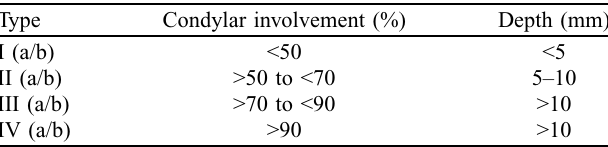
Table 1. Rand classification of bone